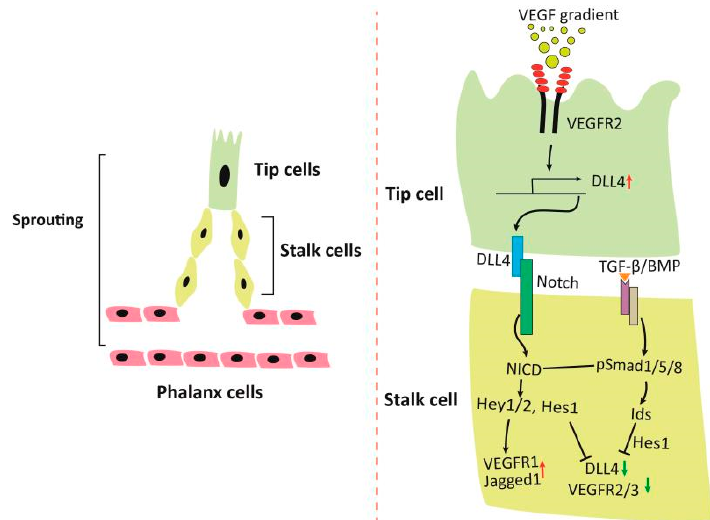
Figure 1. Regulation of sprouting angiogenesis. A gradient of VEGF leads to migration of tip cells and upregulates Dll4, which then activates Notch in the adjacent stalk cells. Expression of Notch target genes maintains phenotype of the stalk cells. TGF- β / BMP signaling cooperates with Notch signaling and regulates sprouting angiogenesis. Abbreviations: Dll4, Delta Like Canonical Notch Ligand 4; Jagged1, a Notch ligand encoded by JAG1 ; NICD, Notch intracellular domain; TGF- β / BMP, transforming growth factor-beta / bone morphogenetic protein; Smad1 / 5 / 8, transcription factors downstream of TGF- β / BMP; Hey1 / 2, hairy and enhancer of split-related with YRPW motif protein 1 and 2, Notch target proteins; Hes1, hairy and enhancer of split-1, a Notch target protein; Ids, inhibitor of DNA binding proteins; VEGF, vascular endothelial growth factor; VEGFR2 / 3, VEGF receptor 2 and 3.